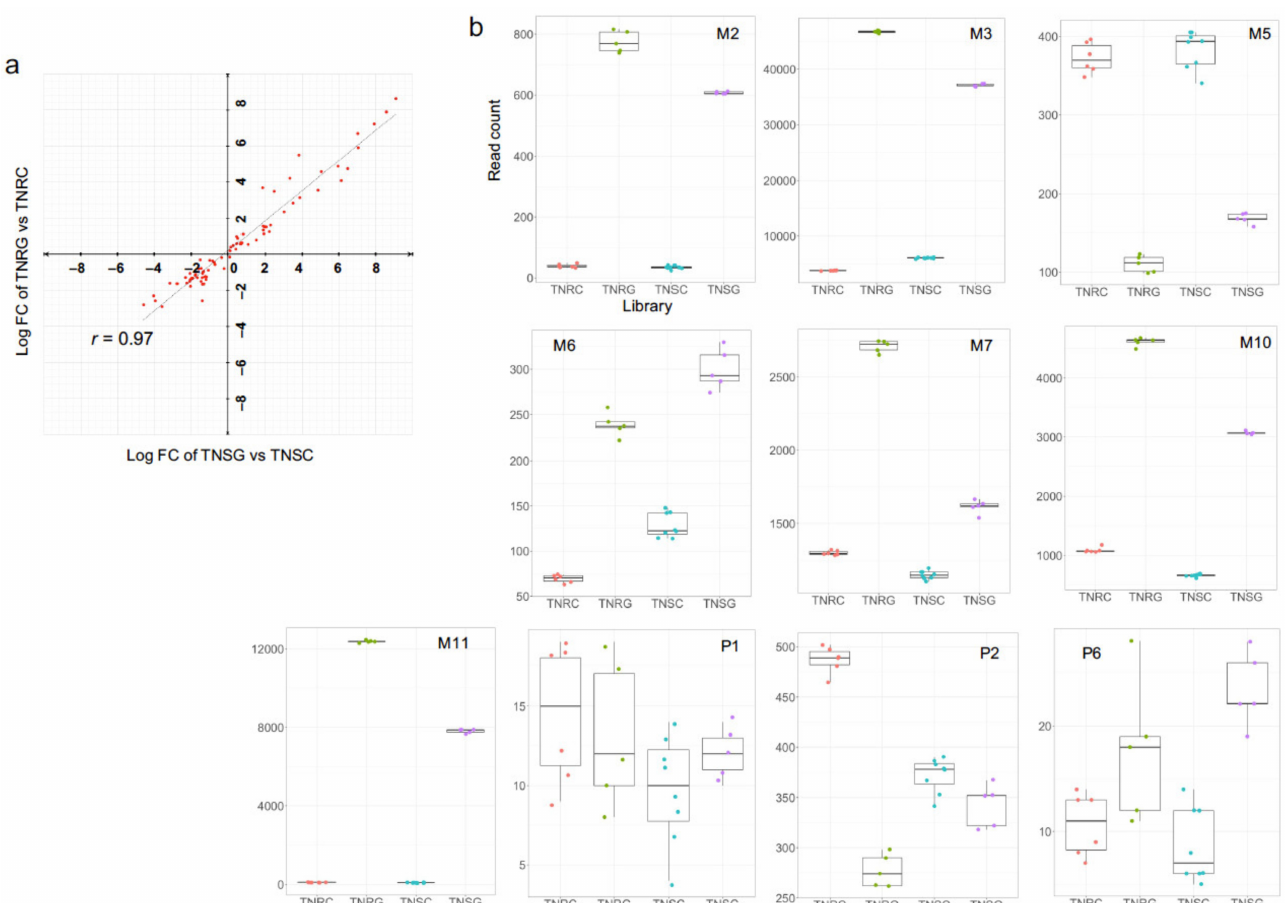
Figure 6. Read counts of representative ABC transporter family genes in TNS and TNR after glyphosate treatment: ( a ) correlation plot of ABC-transporter-assigned transcripts in the DEG analysis of TNRG vs. TNRC, and TNSG vs. TNSC. Note that most ABC transporter gene expression showed similar expression alteration in TNS and TNR after glyphosate treatment; ( b ) Read counts of representative ABC transporter family genes in TNS and TNR after glyphosate treatment. Gene sequences were from previous publication results [21]. Ten transcripts were identified in the present